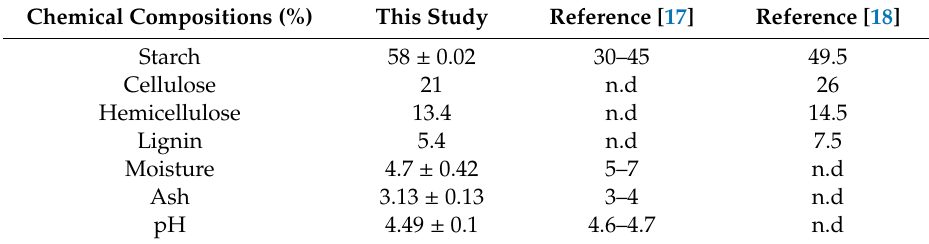
Table 1. Chemical composition of sago